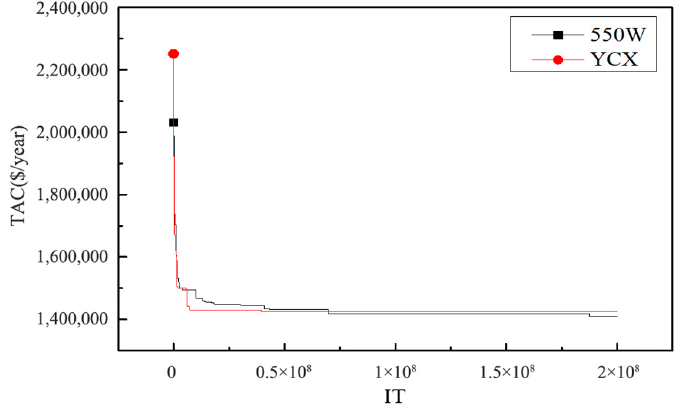
Figure 5. TAC curve of each stream evolution strategy and TAC curve of the original algorithm for Case 1.